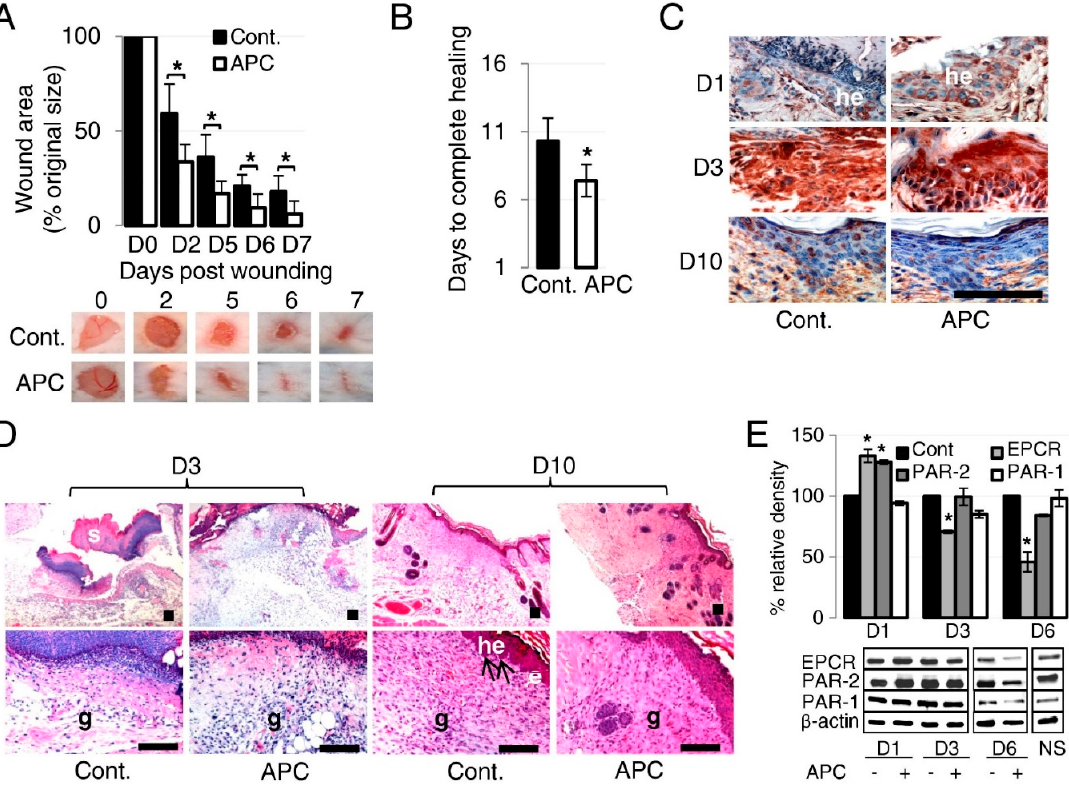
Figure 3. APC accelerates wound healing in wild-type (WT) mice. ( A ) and ( B ) Full-thickness 6-mm diameter wounds were made and treated topically with 20 µL of phosphate-buffered saline or APC (10 µg) once a day for three consecutive days. ( A ) Representative photographs of skin wounds on days after APC treatment. The percentage of wound area/initial area was calculated from tracing the wounds, measured with Visitrak. Values are mean ± SD; n = 10 wounds. * p < 0.05 by paired t -test. ( B ) Time to complete wound closure. Values are mean ± SD; n = 10 wounds. * p < 0.05 by t -test. ( C ) Expression of PAR-2 by immunohistochemistry on wounded skin in WT mice (he: hyperproliferative epithelium). Scale bar = 100 µm. ( D ) Hematoxylin and eosin -stained paraffin sections from day 3 and day 10 wounds from WT mice. Arrows indicate the leading edge of the migrating epithelial tongue (e: epithelium; g: granulation tissue; he: hyperproliferative epithelium; s: scab). Scale bar = 100 µm. ( E ) Expression of EPCR, PAR-1, and PAR-2 detected by immunoblotting from homogenate supernatants of wounded skin (NS: normal skin). The band intensity of the protein was normalized with β -actin, and each control was defined as 100%. Values are mean ± SD; n = 3. * p < 0.05 versus each control on each day by paired t -test. Copyright © 2011 American Society for Investigative Pathology. Published by Elsevier Inc. All rights reserved. Reproduced with permission. License number 4526191003342.